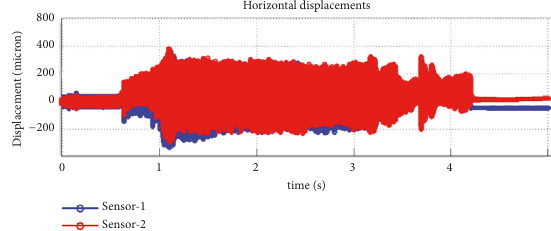
Figure 27: Predicted rotor backward whirl orbit at the DE rotor nodes.